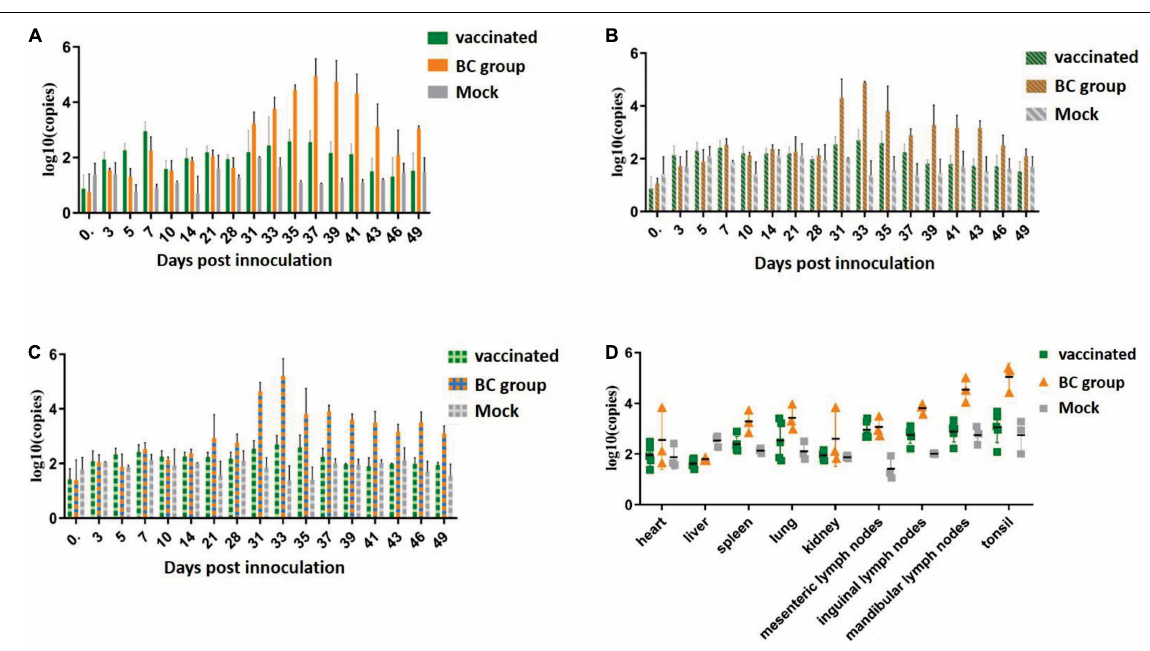
FIGURE 4 | Detection of viremia, virus shedding, and viral load in the tissues by RT-qPCR. (A) Viremia detection in experiments assessing the immune efficacy of rPRRSV-E2 against ZJqz21. (B) Identification of viral RNA in nasal swabs to assess viral shedding. (C) Viral RNA detection in anal swabs to assess viral shedding. (D) Detection of the viral load in the lungs, heart, spleen, liver, kidneys, mesenteric lymph nodes, inguinal lymph nodes, mandibular lymph nodes, and